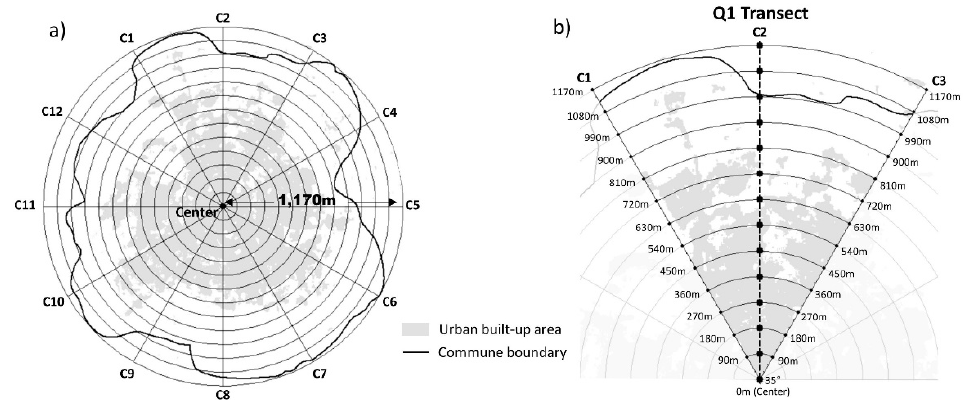
Figure 2. Method of obtaining surface temperatures and deriving urban heat island (UHI) metrics. ( a ) The center of the city is selected based on the ESA built-up class (gray) and a buffer is defined to extend beyond the city limits. A series of axes, connecting the city-center to the buffer edge, are placed uniformly to capture the temperature measurements. Axes are constructed in quadrants: Quadrant 1 (C1–C3), Quadrant 2 (C4–C6); Quadrant 3 (C7–C9); and Quadrant 4 (C10–C12); ( b ) Along each axis, temperatures are produced at 90-meter intervals by averaging each Landsat 30-m data point, then the quadrant temperature is obtained by averaging the 90-m temperatures from the 3 axes. For example, the temperature in Quadrant 1 is obtained by averaging the temperatures from C1, C2 and C3 axes.